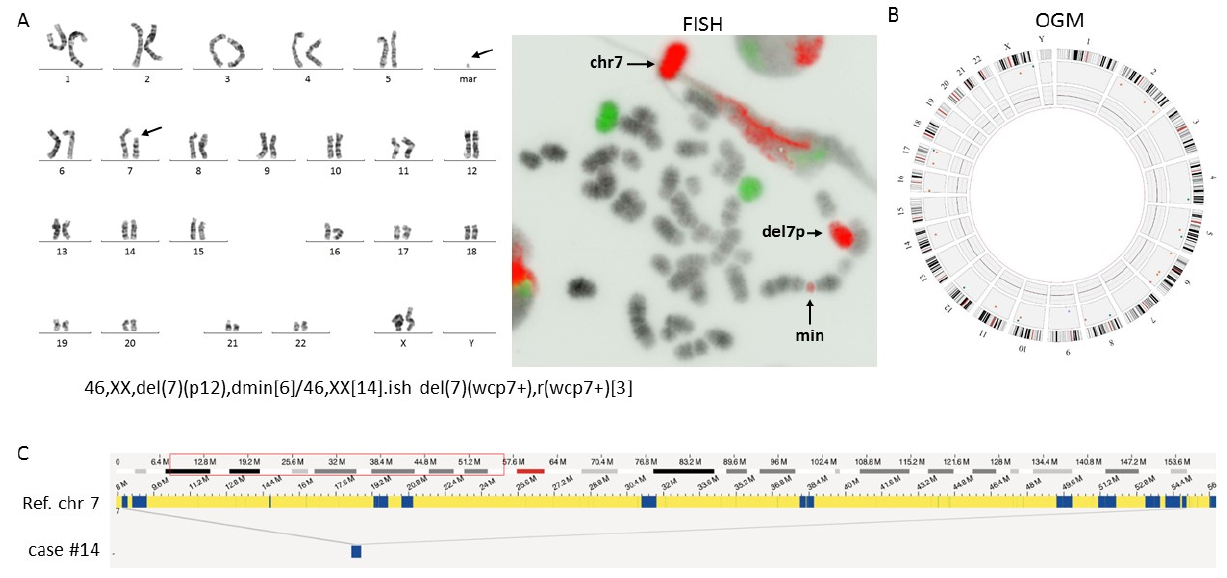
Figure 2. Cytogenetic and OGM results for case #14. ( A ) CBA showed a large deletion of the short arm of chromosome 7 associated with the presence of a minute chromosome; FISH performed with painting probes (MetaSystems) of chromosomes 7 (in red) and X (in green) showed that the minute chromosome was composed of chromosome 7 material. The karyotype is defined to reflect CBA and FISH results (×100). ( B ) The Circos plot obtained by OGM analysis showed no CNV or SV. ( C ) Visual inspection showed a genomic map connecting positions 8.44 Mb and 54.8 Mb on chromosome 7p. Ref. = reference genome, chr = chromosome.